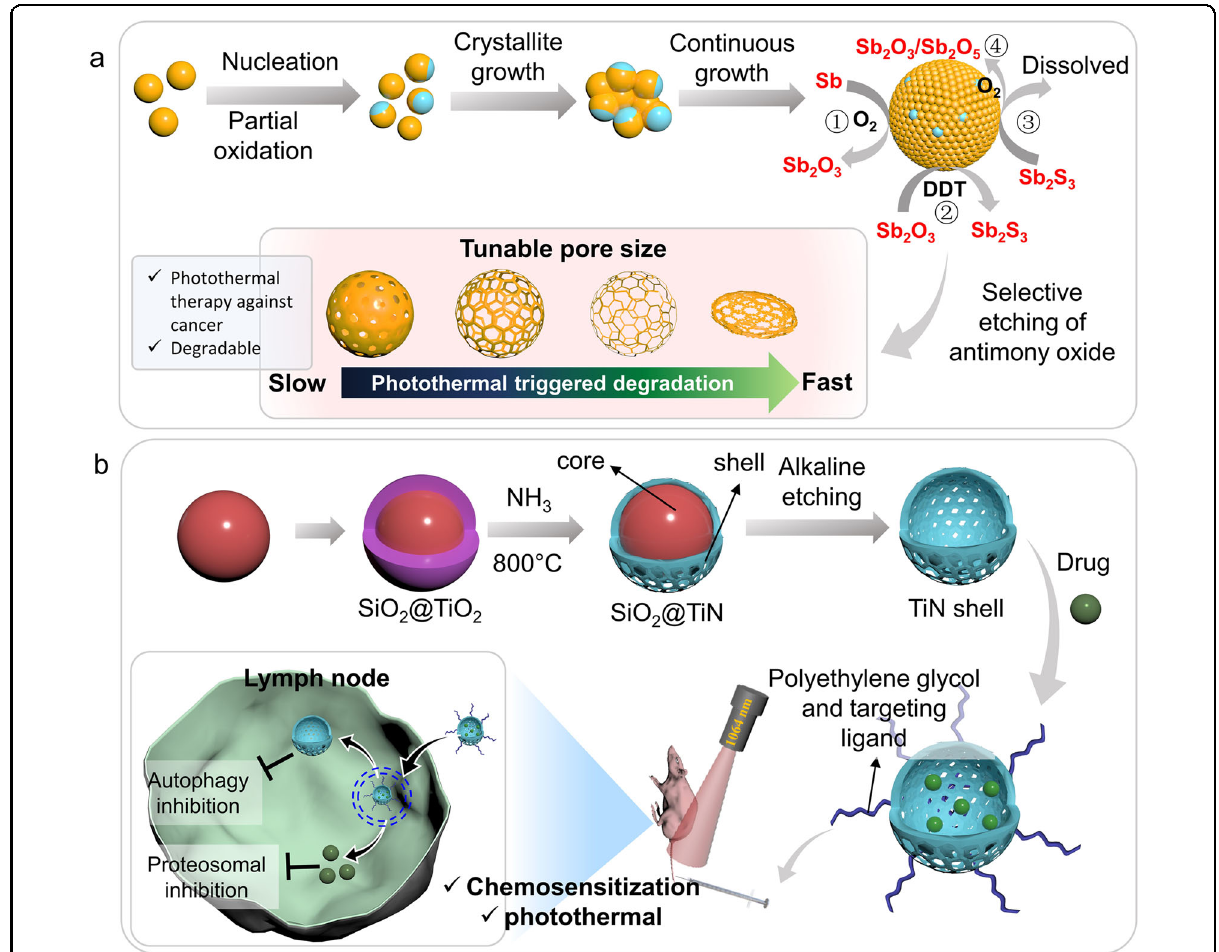
Fig. 12 Mesoporous nanoparticle platforms for photothermal therapy against cancer. a Adjustable physicochemical property of photothermal-based materials and ( b ) photothermal-based polymer